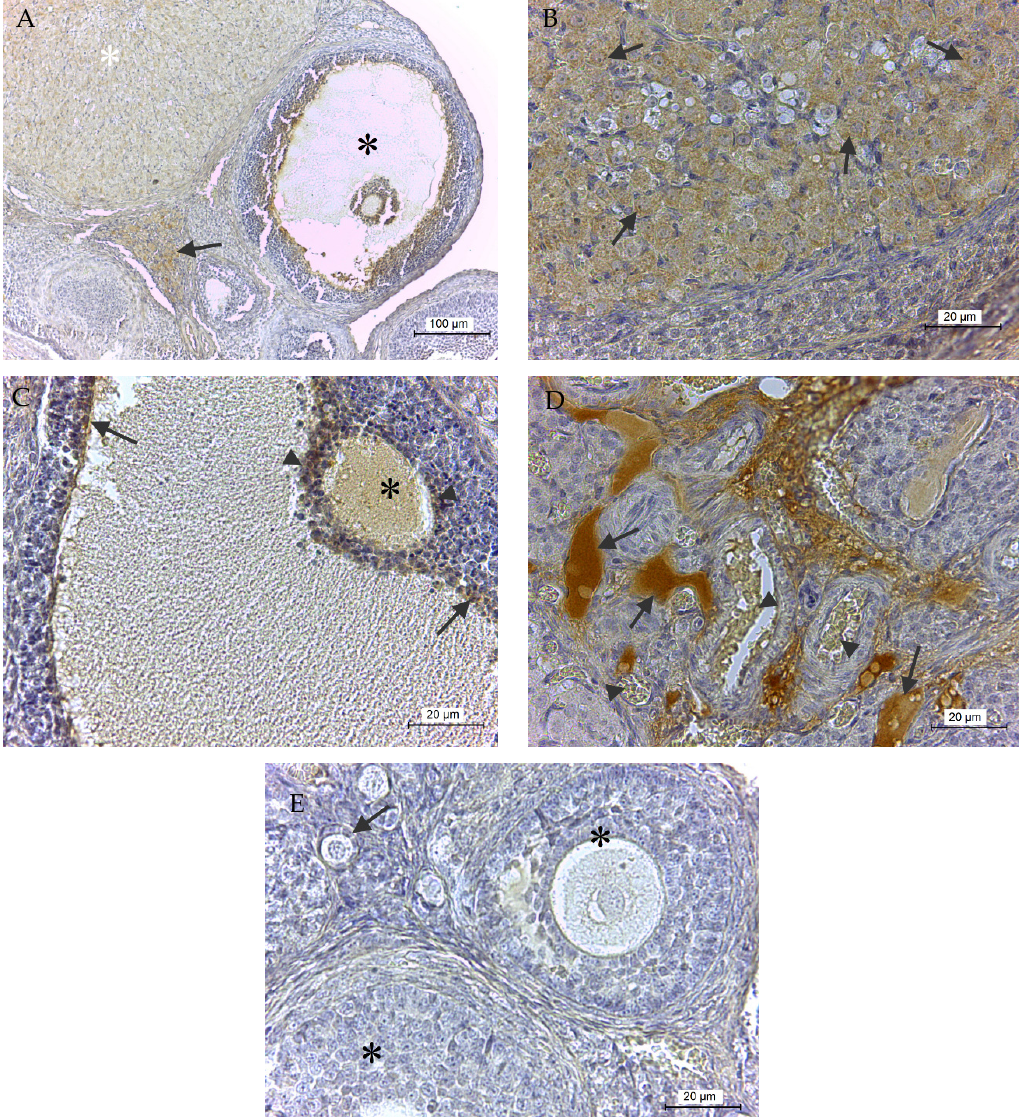
Figure 2. GPx8 presence in rat ovary. ( A ) shows an overall view of protein presence, where white asterisk means corpus luteum, the black asterisk means atretic Graafian follicle, and arrow means ovarian stroma. In detail, the protein was detected in granulosa-lutein cells (arrows) of corpus luteum ( B ), in the cytoplasm of the oocyte (black asterisk), in cells of corona radiata (arrowheads), in the innermost layer of granular cells (arrows) of atretic Graafian follicle ( C ), and in plasma in blood vessels (arrows) but not in erythrocytes (arrowheads) in ( D ). The enzyme was never detected in primary (arrow) and secondary follicles (black asterisk,) in ( E